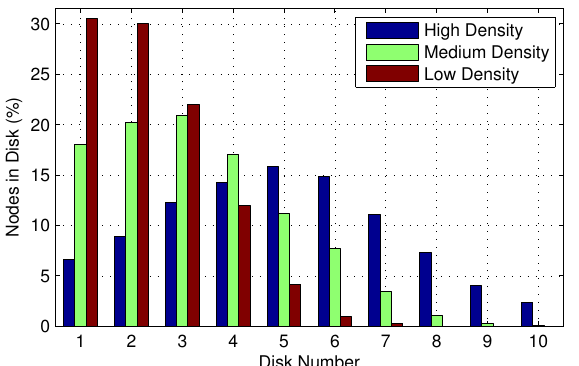
Figure 8. Nodes in the disk for EDS.